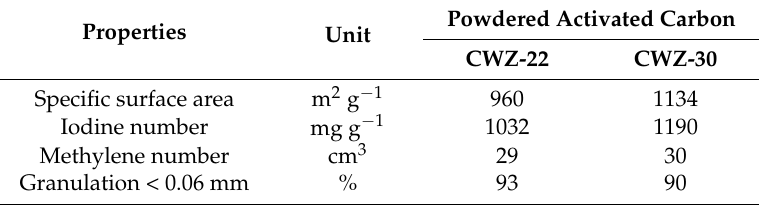
Table 1. Selected properties of powdered activated